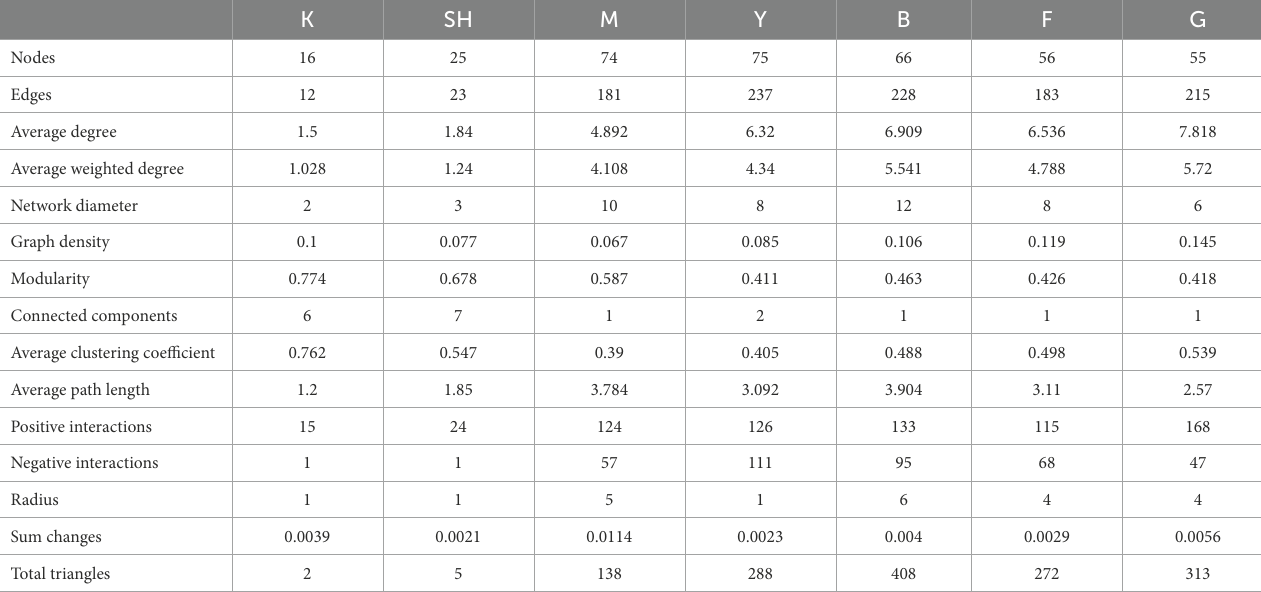
TABLE 2 Topological features of site-specific co-occurrence network in Figure